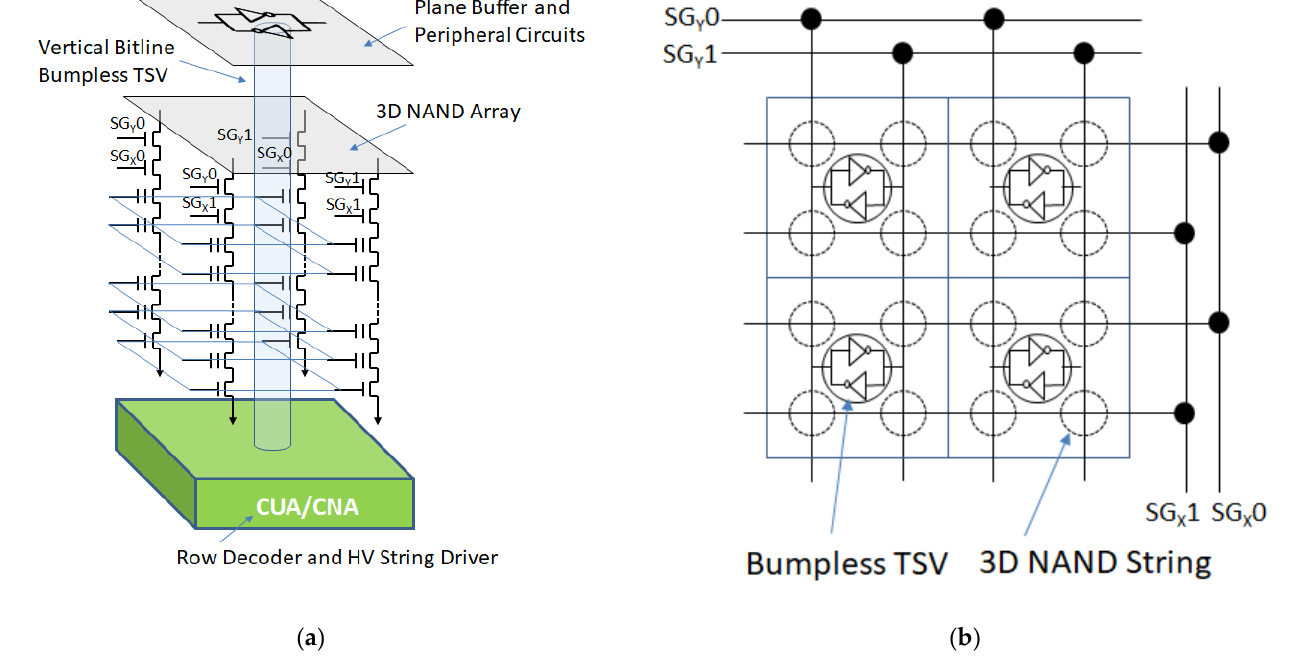
Figure 41. Vertical bitline architecture. ( a ) bird’s eye view; ( b ) top view.